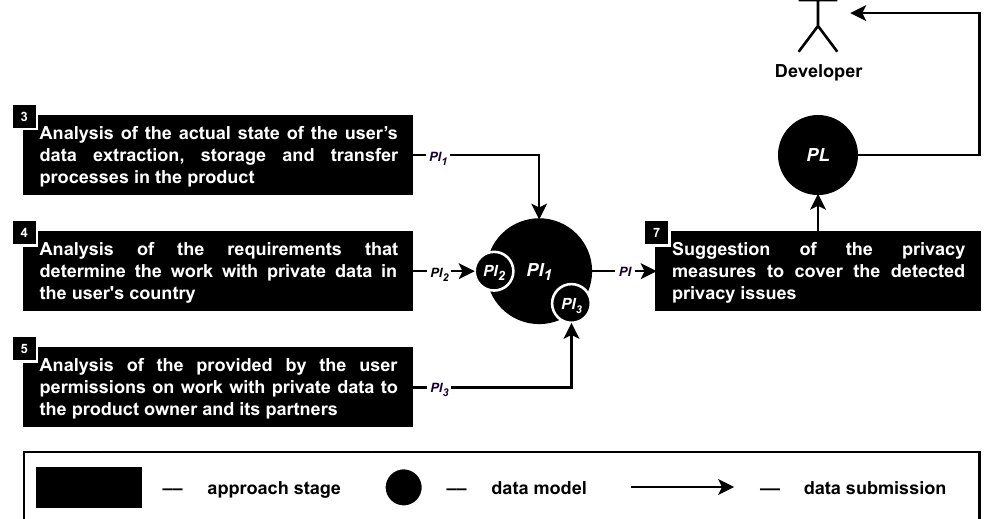
Figure 10. Stage 7—Suggestion of the privacy